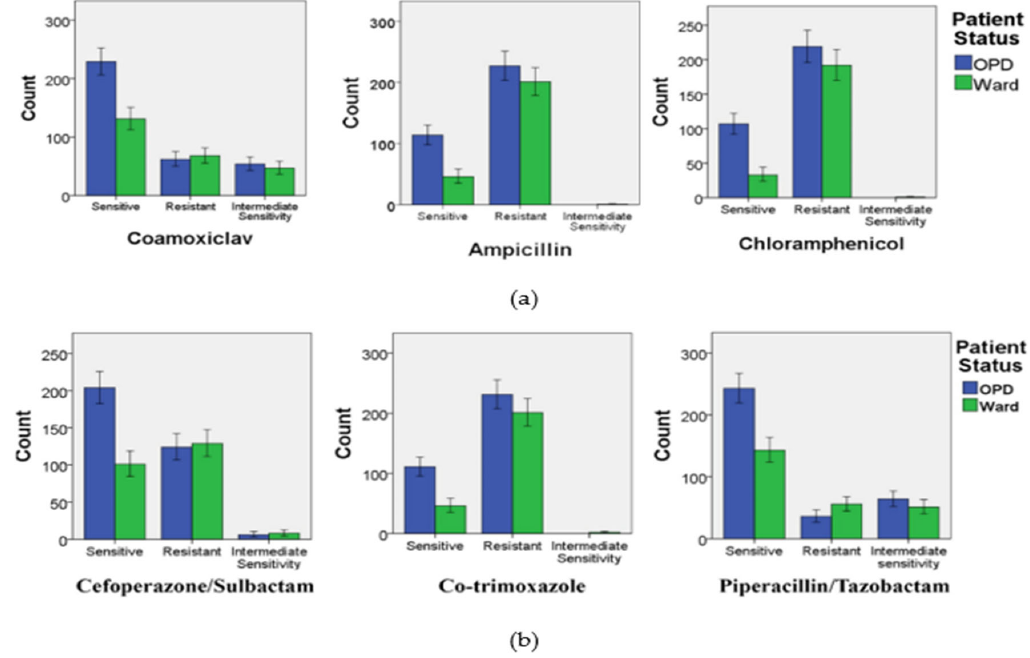
Figure 4. The occurrence of resistant S. Typhi strains against ( a ) co ‐ amoxiclav, ampicillin, and chloramphenicol and ( b ) cefoperazone, co ‐ trimoxazole, and piperacillin/tazobactam in OPD and ward patients .